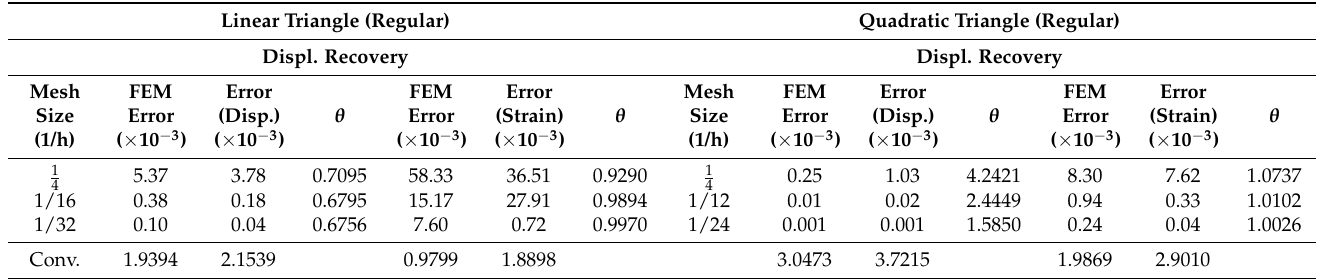
Table 1. Error in displacement and strain (L 2 -Norm) and global effectivity ( θ ) in compressible elastic square plate example considering displacement recovery technique.